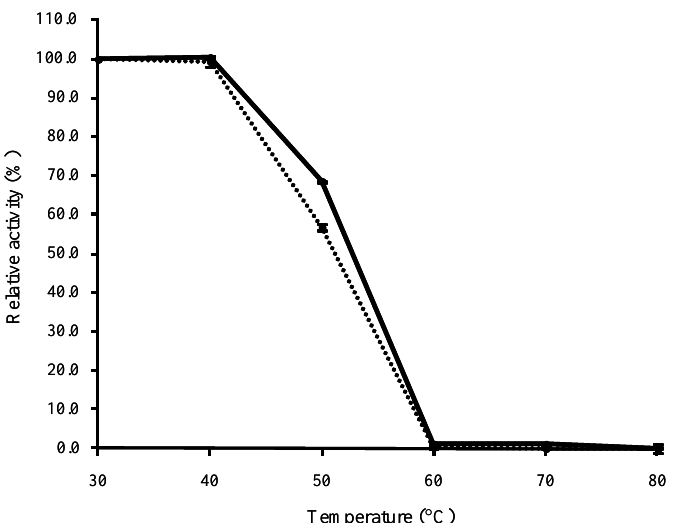
Figure 6. Temperature effects on the stability of the LX-20  -galactosidase. Symbols represent the free form enzyme (dotted line) and the immobilized form enzyme (solid line). Data were expressed as mean and standard errors from three experiments.